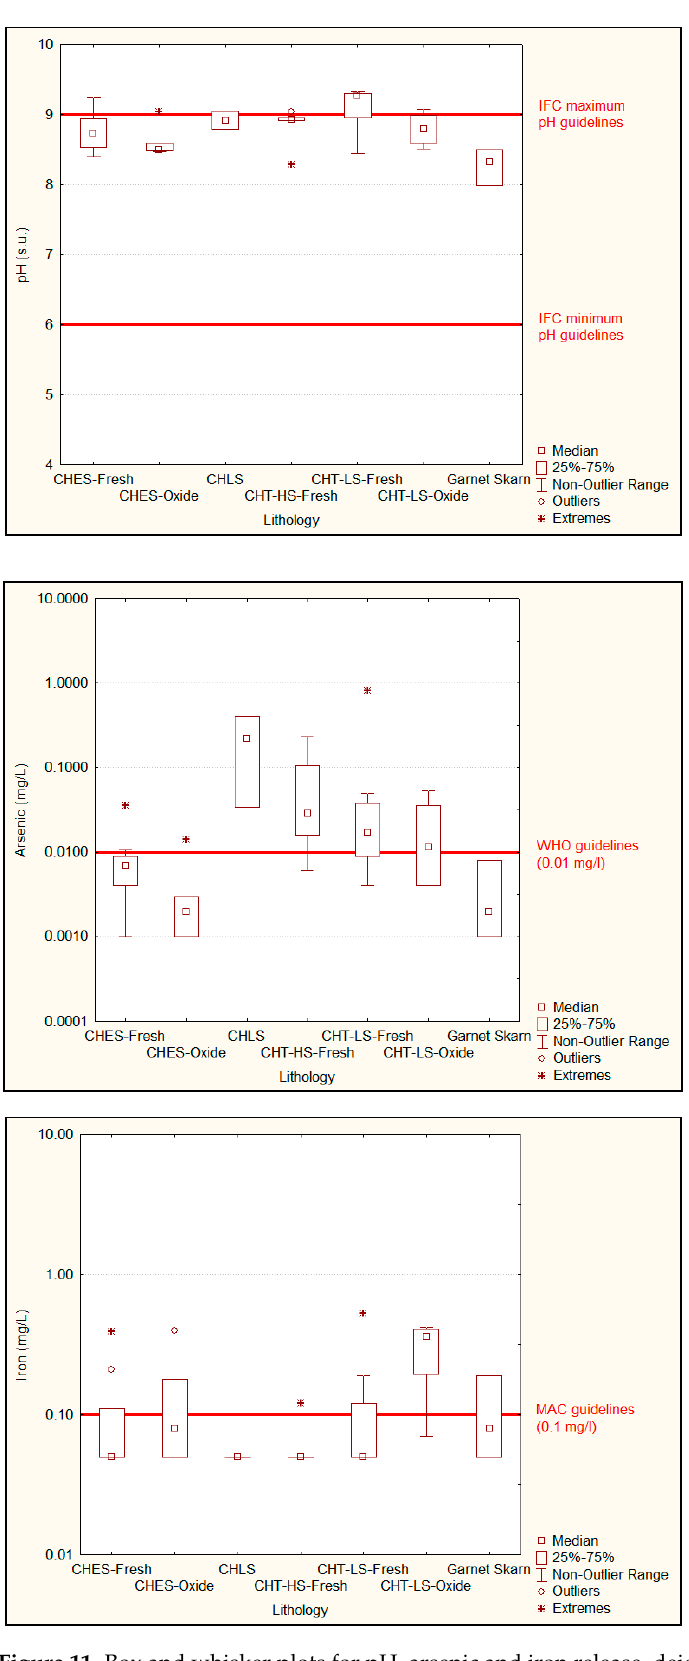
Figure 11. Box and whisker plots for pH, arsenic and iron release, deionized water leach. The release of arsenic during the deionised leach at concentrations in excess of the World Health Organization guideline value of 0.01 mg/L indicates it is potentially the most problematic element at Hrazdan due to the human health risks it poses to people and the close proximity of a potable water supply (Figure 4) to the proposed mine site as well as to aquatic ecosystems. However, despite the elevated concentrations of arsenic in all material types (as identified in the multi element assay) it is only the chert and chlorite skarn material types that regularly exceed the guideline limits. A possible explanation for this is the presence of iron oxide and oxyhydroxide minerals (e.g., goethite [FeOOH]) in relatively high abundance within the chlorite-epidote skarn (CHES) and garnet skarns material types. At circum-neutral pH arsenic will strongly adsorb to iron oxyhydroxide minerals and therefore the presence of these minerals within these material types may be acting to attenuate the arsenic from the solution. This relationship is tentatively shown in Figure 12 which shows that those samples with the lowest total iron (as measured by the whole rock assay) show the greatest capacity to leach arsenic. An aggressive hydrogen peroxide leach was undertaken on the waste rock core sam- ples in order to assess the potential for high level metal release. This involved analysis of the NAG test leachate for a full suite of metal and metalloid ions. The results of the hy- drogen peroxide leach for key parameters relating to ARDML are summarised in Table 7. This shows the amount of elemental leaching during the hydrogen peroxide leach com- pared to whole rock concentrations (as determined from the multi-element analysis) to allow determination of the potential mobility of enriched elements under intensive oxi- dising conditions Table 7. Summary of hydrogen peroxide leach results for the waste rock samples. All values in mg/kg. Lithology